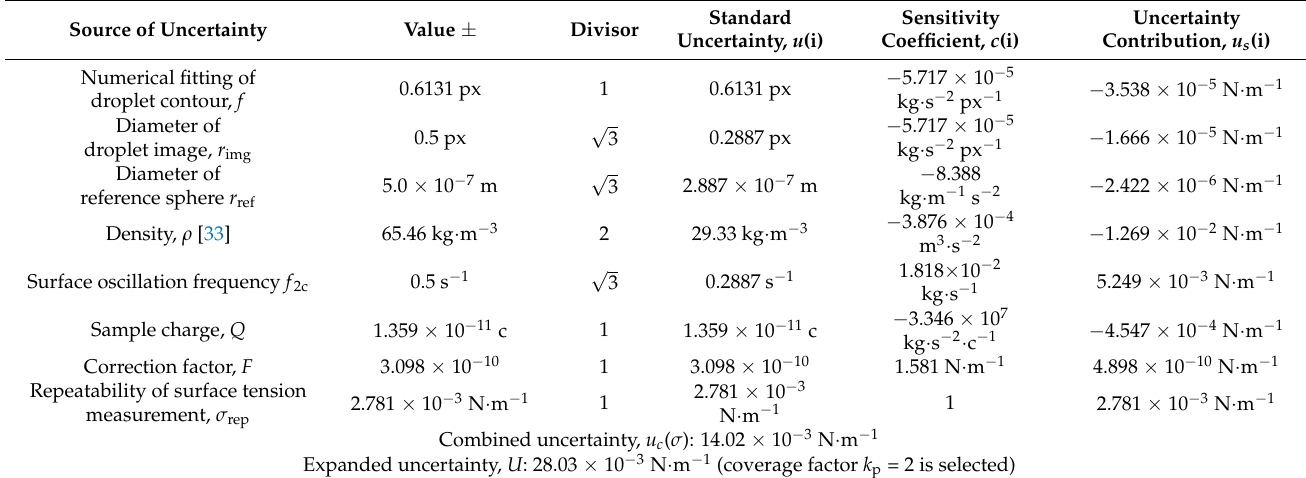
Table 4. Uncertainty budget of surface tension measurements of liquid titanium by ESL when the calculation result of uncertainty for the measurement plot showed the largest